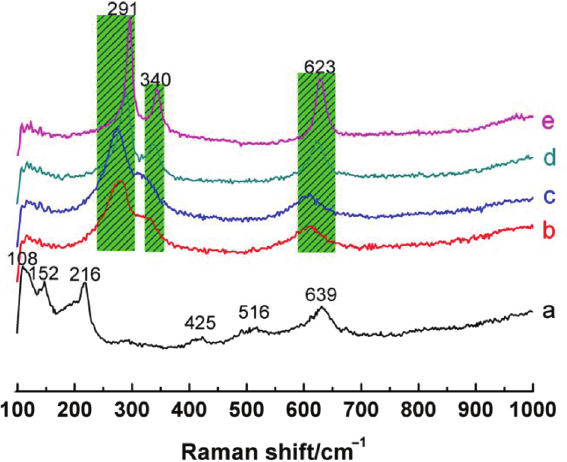
Figure 9: Raman spectra of CuCl residue before and after microwave roasting at 450°C: (a) raw materials, (b) 30 min, (c) 60 min, (d) 90 min and (e) pure copper